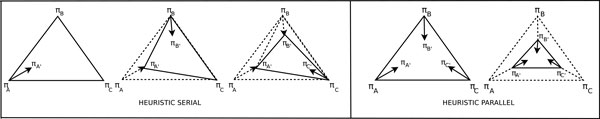
Heuristics Serial and Parallel. A schematic of Heuristic Serial and Heuristic Parallel.